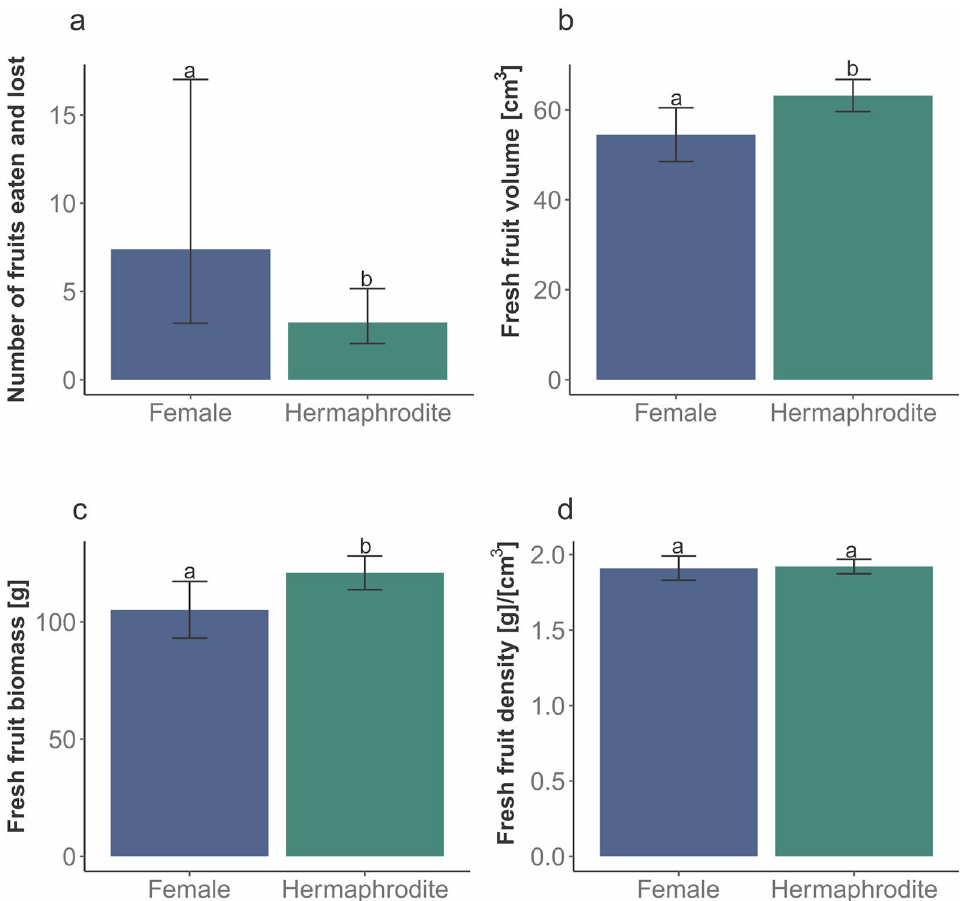
Figure 4. Comparison of the reproductive biomass traits for hermaphrodite and female Opuntia robusta plants growing in central Mexico. We estimated a) the number of fruits eaten by fructivores in hermaphrodite and female individuals, as well as b) the fruit volume [cm 3 ], c) fruit biomass [g], and d) fruit tissue density [g × (cm 3 ) −1 ]. More female fruits were consumed than hermaphrodite fruits ( a ). The average volume and average biomass of the ripe hermaphrodite fruits was significantly greater than that of the female fruits ( b and c ). Average fruit density was not significantly affected by sexual forms ( d ). We fitted a generalized linear model for fruit number with negative binomial error distribution, as well as for the volume, fresh biomass, and density, using the Gaussian distribution and a log link function. Different letters denote significant differences between the mean values at P ≤